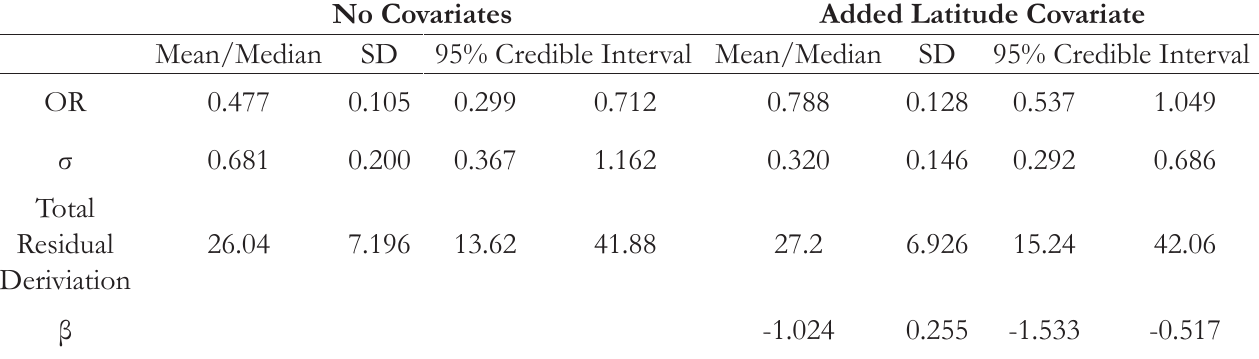
Table 4. Meta-regression